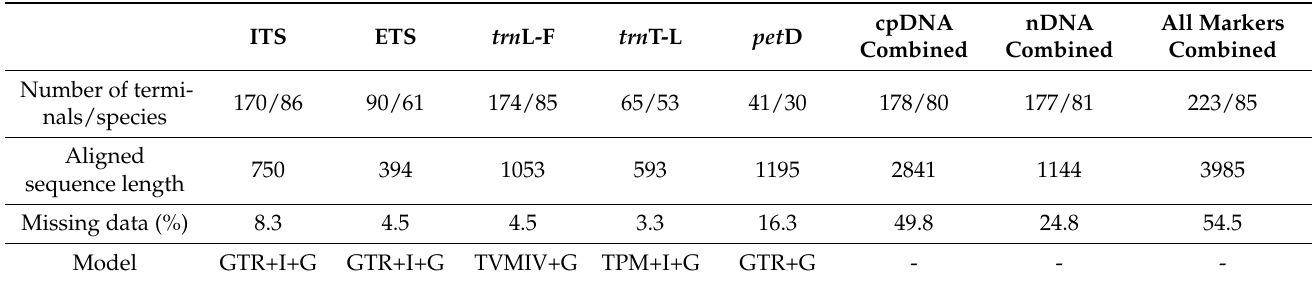
Table 1. Descriptive statistics of the separate and combined DNA datasets used in the phyloge- netic